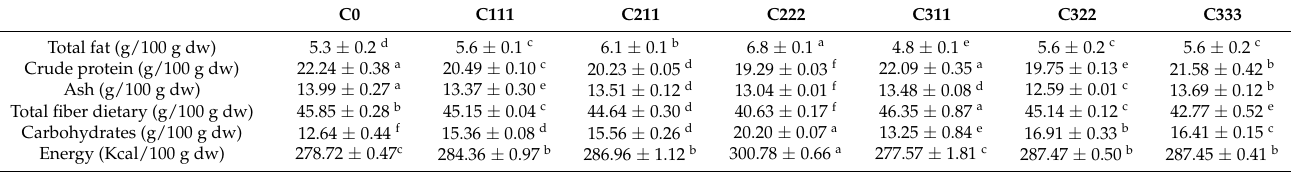
Table 2. Nutritional profile and energetic value of C. spinosum (mean ±